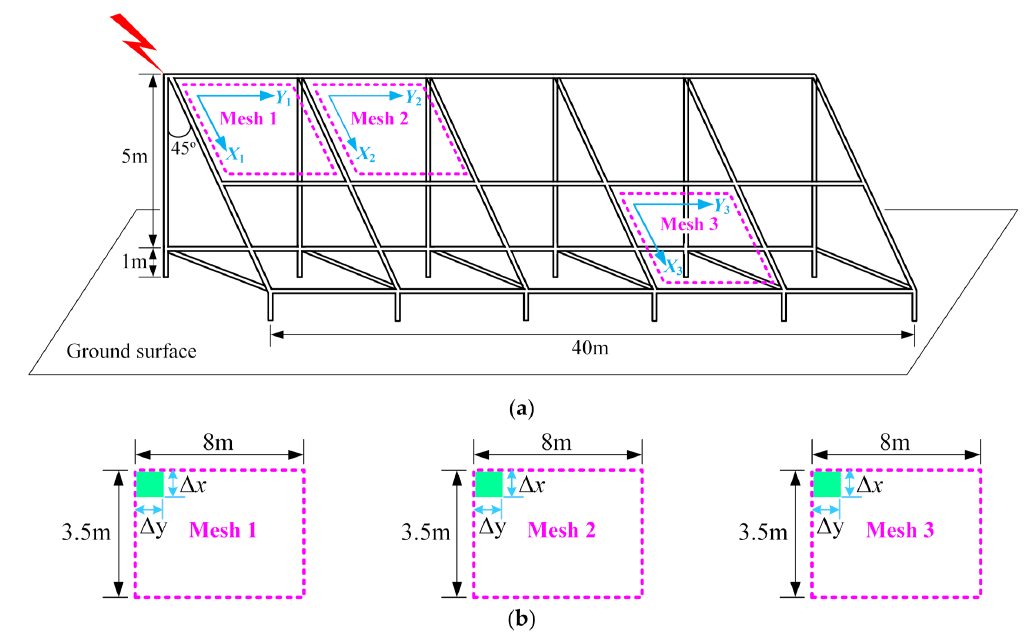
Figure 10. ( a ) PV bracket system, ( b ) three